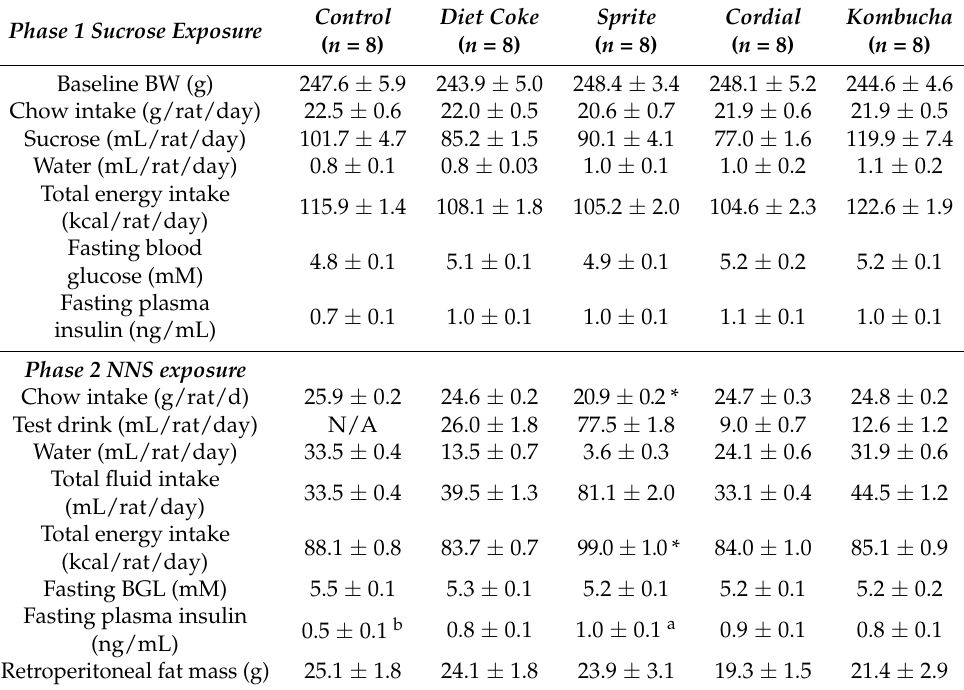
Table 3. Male group means ± SEM for sucrose exposure in Phase 1 and NNS exposure in Phase 2. Phase 1 Sucrose